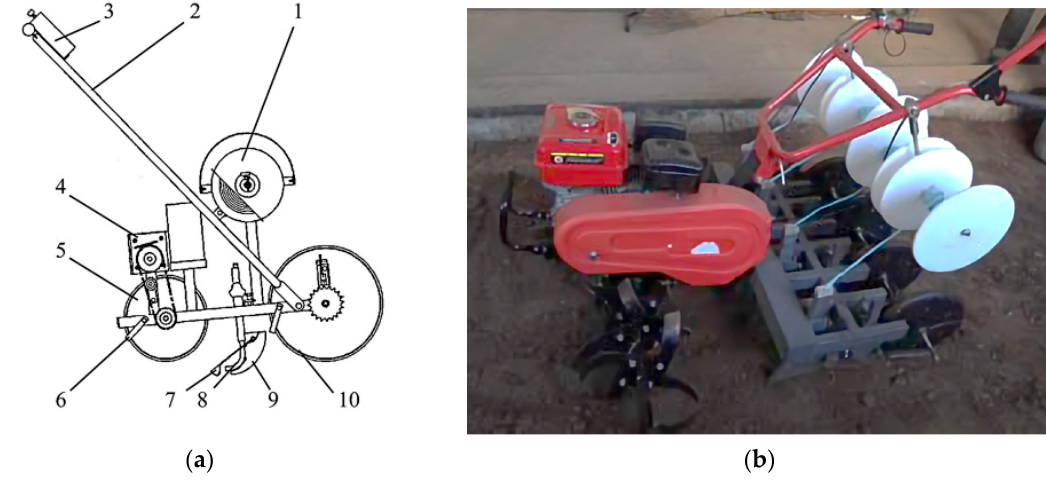
Figure 9. Two kinds of hand-guided types of tape planter. ( a ) Seed tape planter designed by Ryosumi (https://patentimages. storage.googleapis.com/7b/82/a3/adb74f12120c19/JP2012235727A.pdf (accessed on 20 November 2021)) [90]; ( b ) Seed tape planter designed by Lv [92]. 1. Seed tape disc 2. Pushrod 3. Switch 4. Motor 5. Pressing wheel 6. Scraper plate 7. Scriber 8. Seed tape guiding pipe 9. Furrow opener 10. Walking